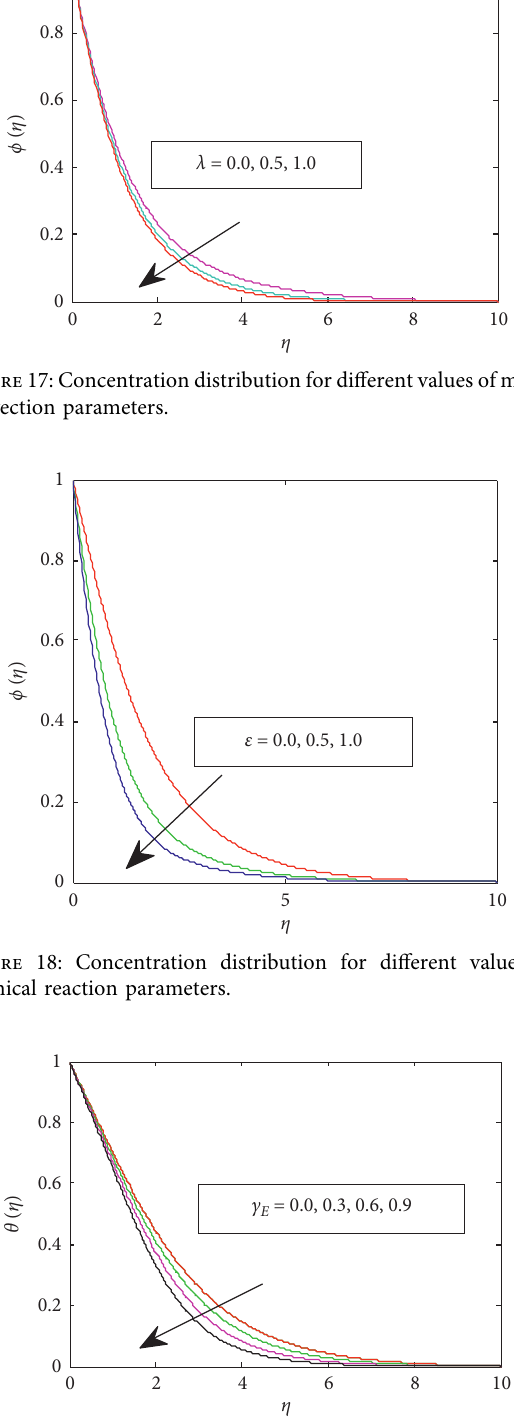
Figure 19: Temperature distribution for different values of c